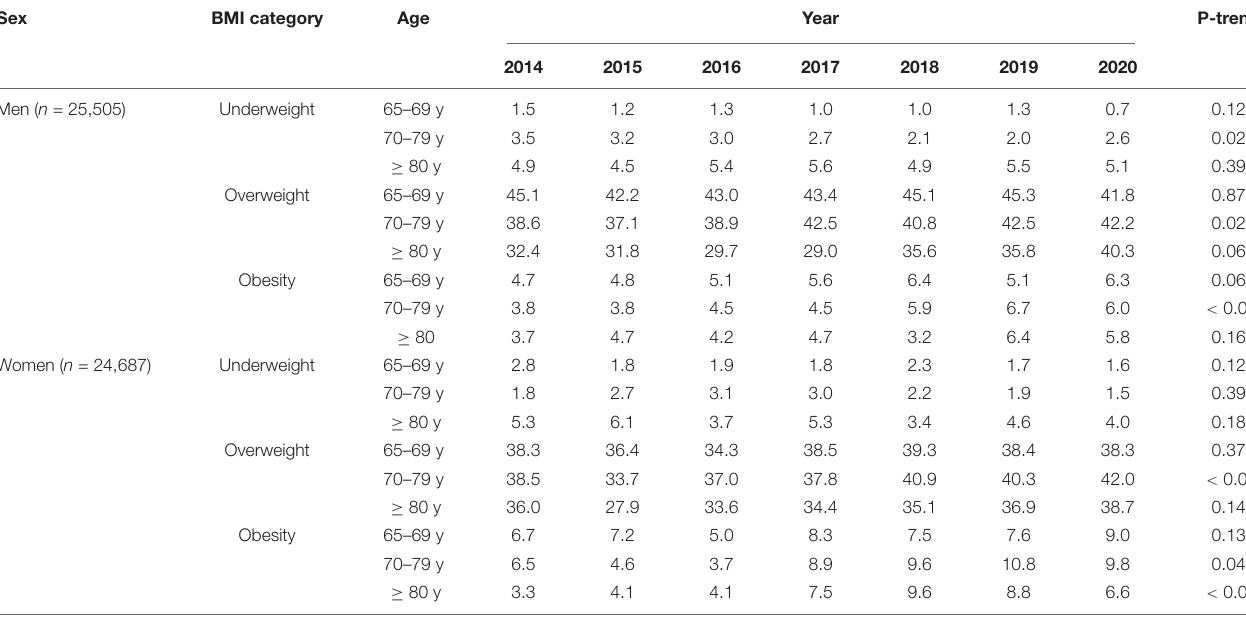
TABLE 4 | The prevalence of underweight, overweight and obesity in 50,192 Chinese aged participants from 2014 to